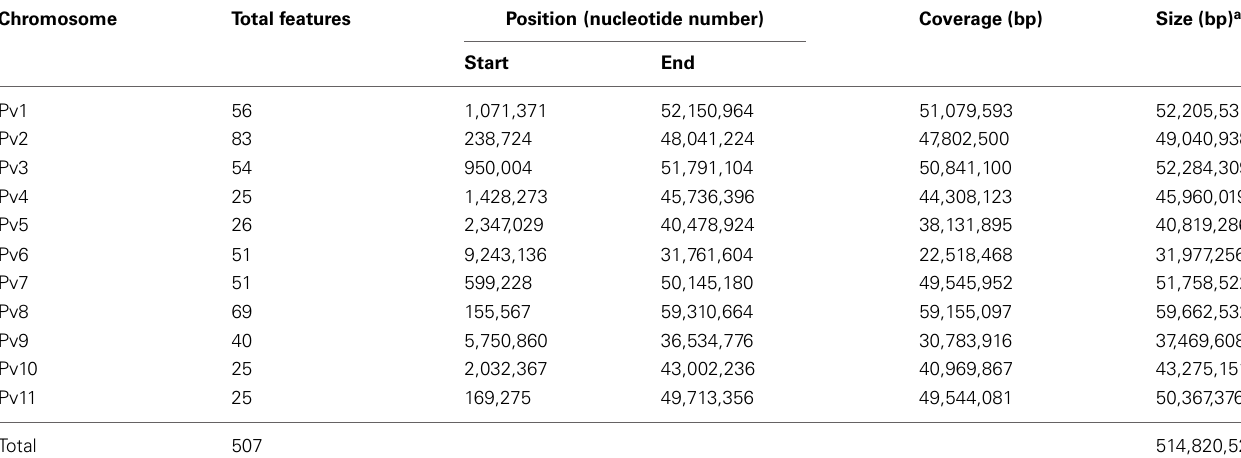
Table 4 | Characteristics of common bean phenylpropanoid pathway gene-based sequence map. Chromosome